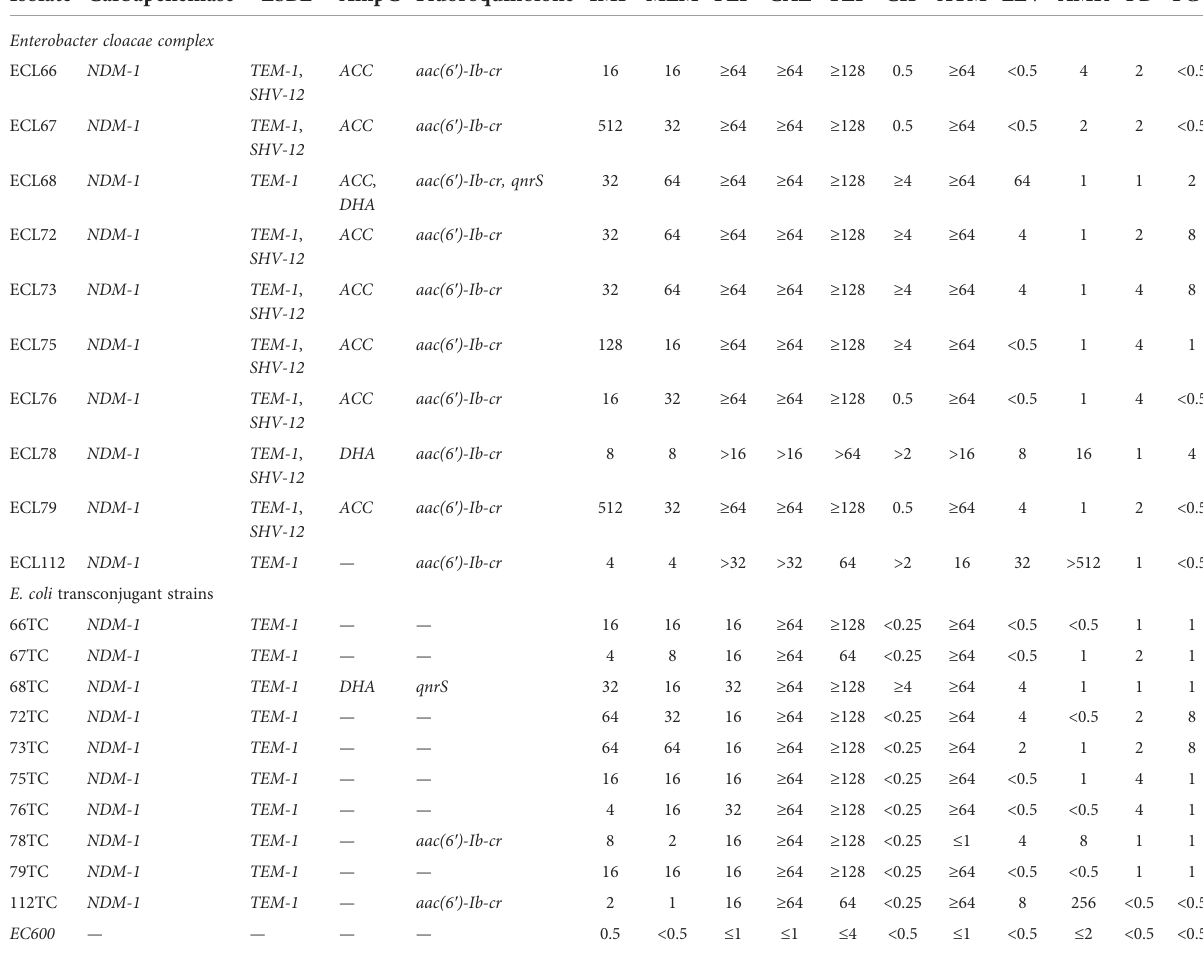
TABLE 2 Antibiotic susceptibilities and resistance determinants of E. cloacae isolates and their transconjugants ( m g/ml). Isolate Carbapenemase ESBL